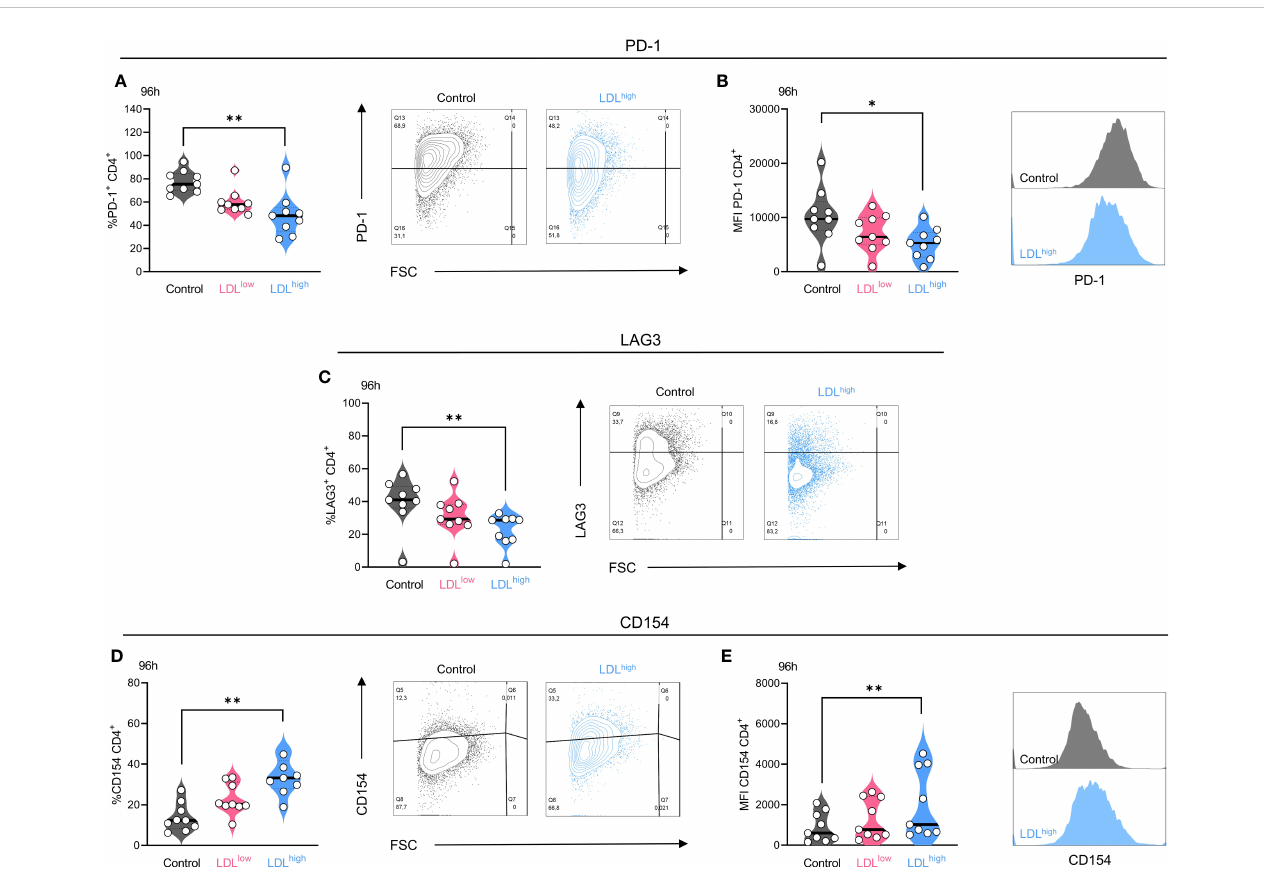
FIGURE 3 The exhaustion markers PD-1 and LAG-3 were down-regulated in the presence of LDL high (here shown for the CD4 + subset after 96 h) and the costimulatory marker CD154 (CD40L) was upregulated in the CD4 + T cell subset. T cells were freshly isolated and stimulated with anti-CD3/CD28 beads, IL-2 and treated with different LDL dosages (LDL low = 50 µg/ml and LDL high = 200 µg/ml) versus medium control. PD-1: LDL high signi fi cantly reduced the fraction (A) of PD-1 + cells and the expression (B) of PD-1 on the CD4 + T cell subset after 96 h. Representative FACS plots and histograms are presented (A,B). LAG-3 : LDL high signi fi cantly reduced the fraction of LAG-3 + cells in the CD4 + T cell subset after 96 h. Representative FACS plots are presented (C) . CD154 : The fraction of CD154 (CD40L) positive cells (D) and the expression (E) of CD154 was signi fi cantly enhanced in the presence of LDL high in the CD4 + subset. Representative FACS plots and histograms are presented (D,E). Depending on normal or non-normal distribution, RM one-way ANOVA with Geisser-Greenhouse correction and Dunnett`s multiple comparison test or Friedman test with Dunn`s multiple comparison test was performed. Signi fi cance was indicated as p < 0.05 *, p < 0.01 ** referring to control. All data were corrected for multiple testing according to Benjamini and Hochberg.